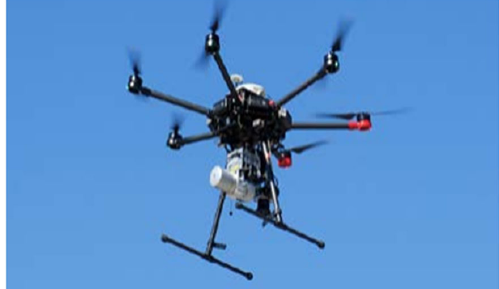
Figure 1. UAV-LiDAR System (Phoneix, 2023)